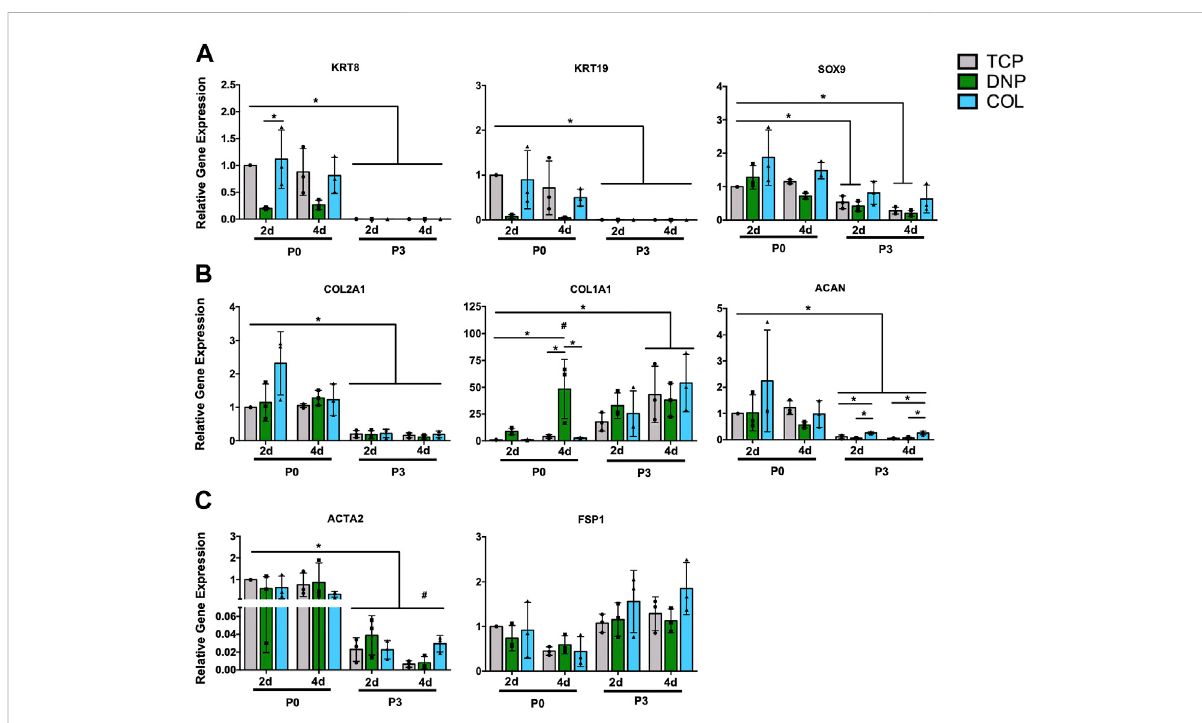
FIGURE 5 RT-qPCR gene expression analysis of primary bovine NP cells following short term culture in monolayer on tissue culture plastic or ECM coatings. Un-passaged (P0) and late passage (P3) primary bovine NP cells were seeded onto tissue culture plastic (TCP), decellularized NP (DNP) coatings, or type I collagen (COL) coatings. Cells were cultured in vitro for 2 days (2d) or 4 days (4d). Gene expression analysis was performed to quantify expression of (A) NP-associated markers ( KRT8, KRT19, SOX9 ), (B) ECM genes ( COL2A1, COL1A1, ACAN ), and (C) fi broblast markers ( ACTA2, FSP1 ). Relative gene expression was determined using the ΔΔ C t method normalized to expression of the housekeeping gene GAPDH , and expressed relative to P0 cells on TCP at 2 days. Data is presented as mean ± SD (N = 3, p < 0.05, * indicates signi fi cant difference between culture conditions, # indicates signi fi cant difference within each condition relative to